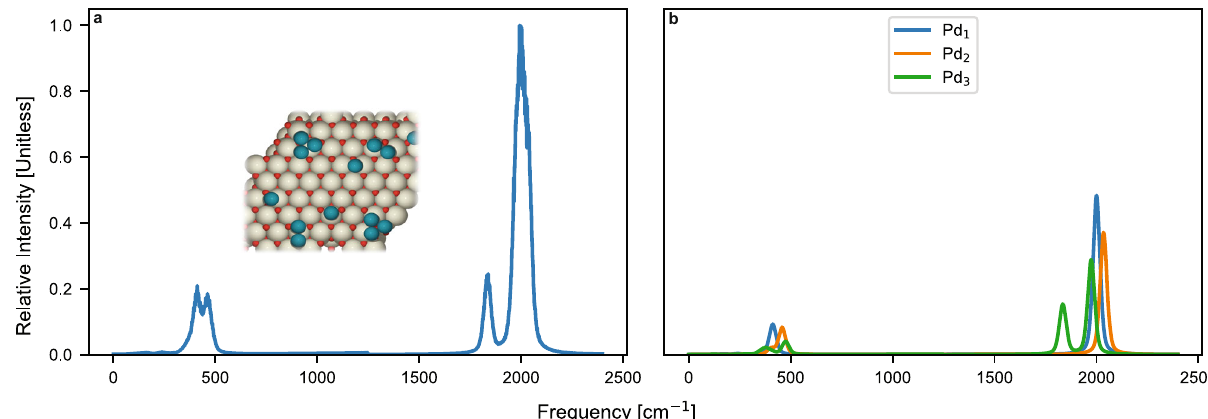
Fig. 5 | Synthetic spectra of a system containing equal fractions of supported Pd/CeO 2 monomers, dimers, and trimers saturated with CO. Here, the relative intensitiesratherthanabsoluteintensities areshown to ignore theeffects ofmetal loading. The intensities of the metal-carbon stretch region (<1000cm − 1 ) are